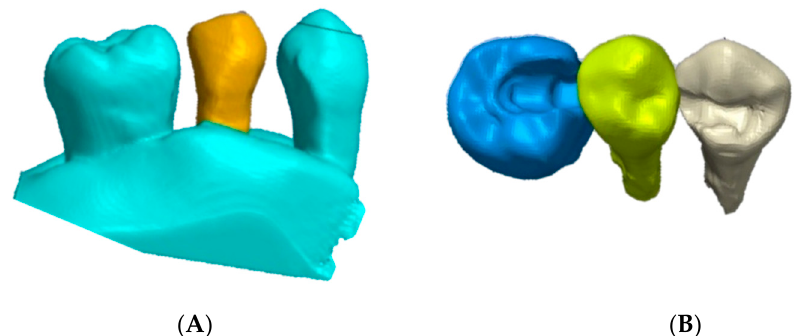
Figure 2. Digital cavity preparations: ( A ) frontal view; ( B ) occlusal view.